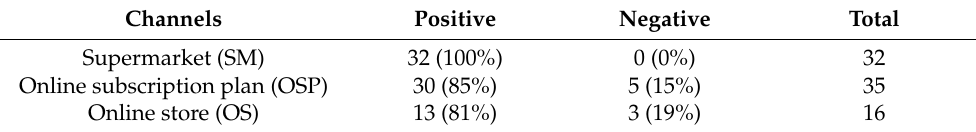
Table 3. Sentiment